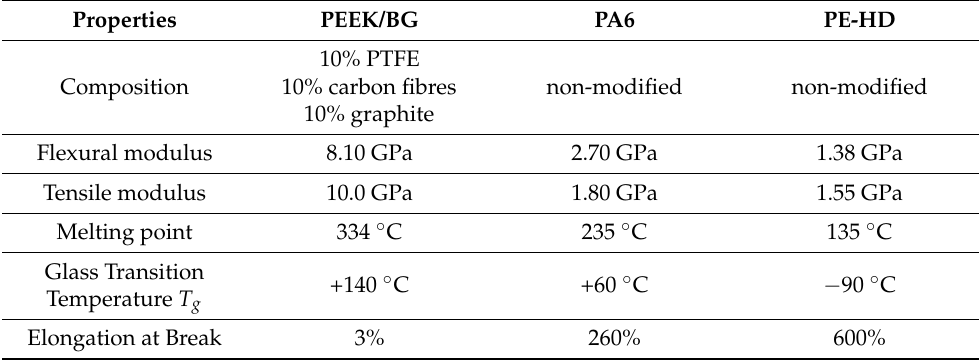
Table 1. Properties of polymeric materials.